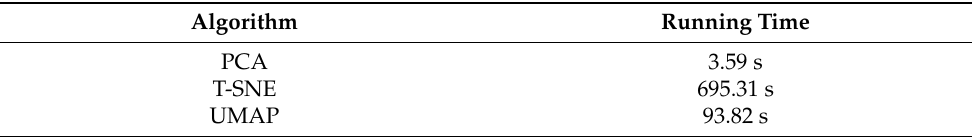
Table 2. Running time of three-dimensionality reduction